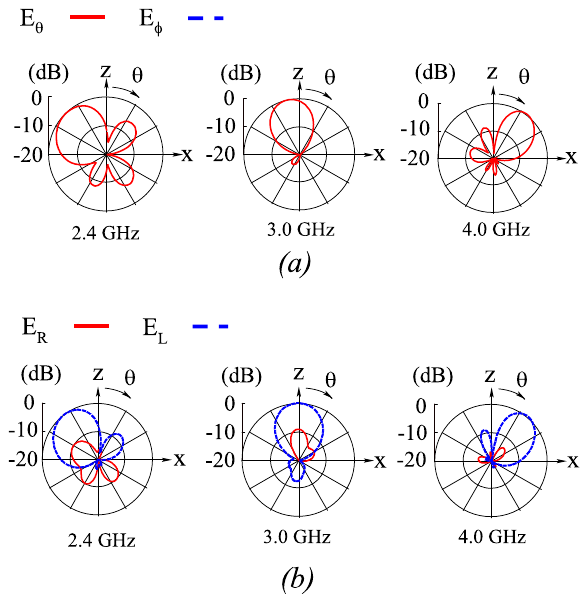
Fig. 5. Radiation from a 10-cell metaline ( N cell =10). The para- meters in Table 1 are used, with R B = 60 V . (a) C-type metaline. (b) N-type